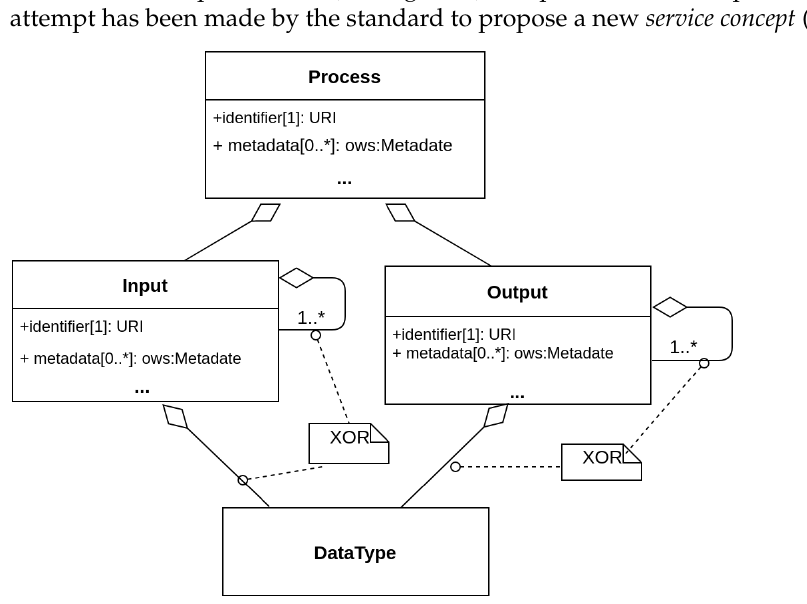
Figure 2. UML Class diagram describing the abstract process model